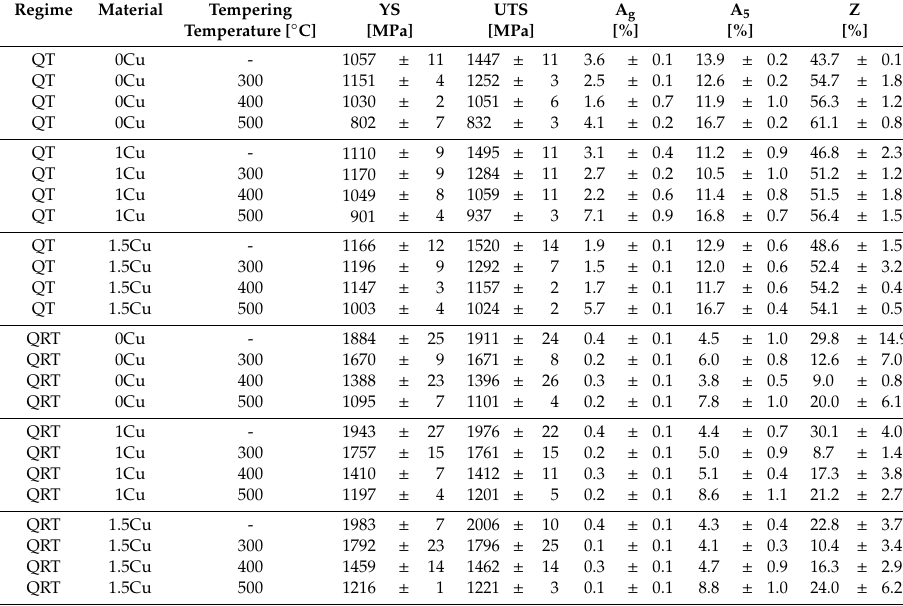
Table A2. Tensile test results for 60 min tempering at di ff erent temperatures. Values of QT samples were taken from